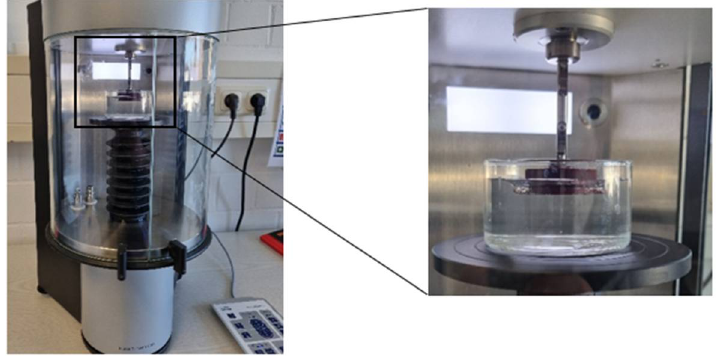
( b ) Figure 6. Determination of the static contact angle by means of drop shape analysis fitting with ( a )